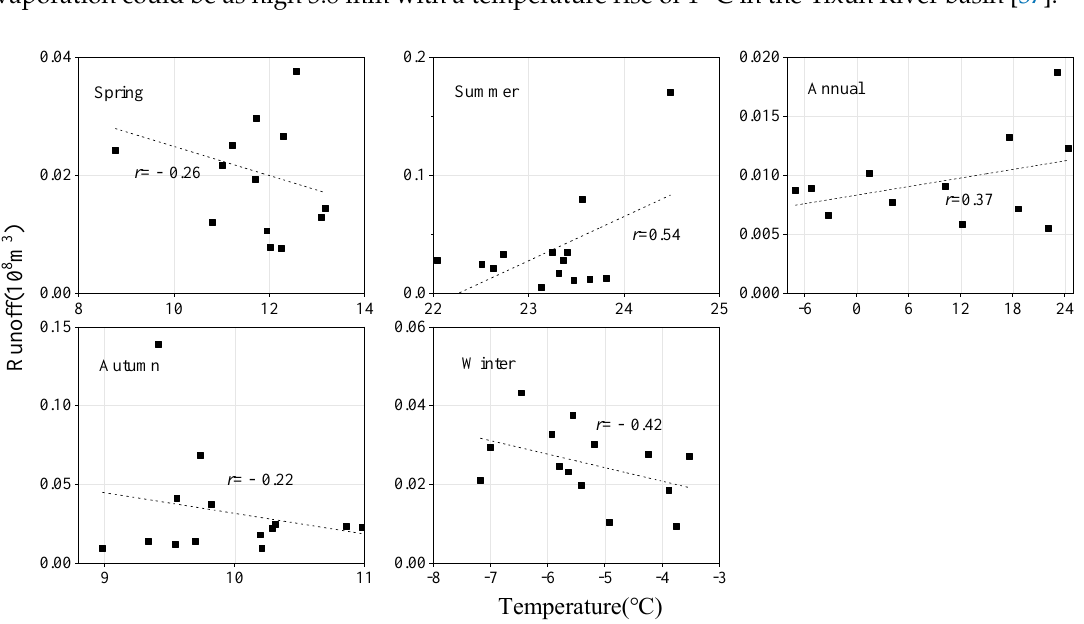
Figure 11. Correlation between mean temperature and runoff at annual and seasonal scales.